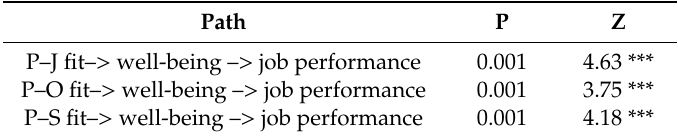
Table 4. Mediating effect of well-being by the Sobel test.